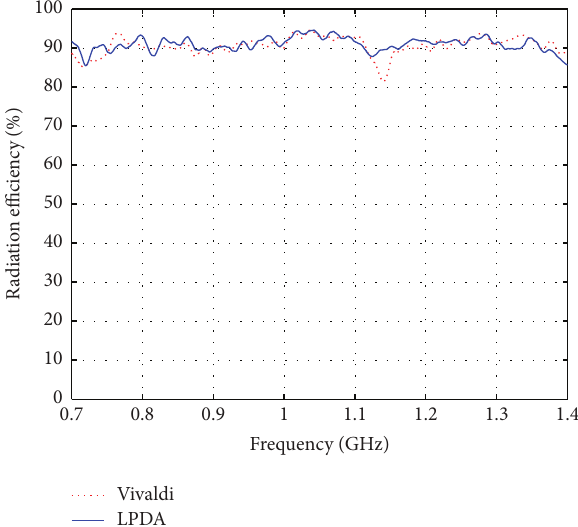
Figure 8: Measured radiation efficiency of antennas using two- antenna method.